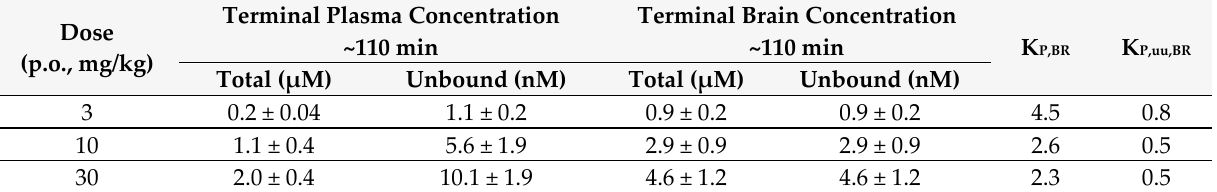
Figure 3. Effect of a single administration of HC-070 (mg/kg, p.o.) on colonic hypersensitivity in the female rat model of partial restraint stress (PRS). ( A ) Results of the colonic distension threshold (mmHg) evoked by the colorectal distension test are expressed as the mean of three trials, the error bars represent SD, n = 10/treatment group, and each symbol represents an individual data point. Percentages are expressed as colonic anti-hypersensitivity activity of HC-070 and morphine, or as percentage of variation as compared to naive animals. **, ***: p < 0.01 and p < 0.001, respectively, as compared to the vehicle-treated PRS group, Dunnett’s test after significant one-way ANOVA. ( B ) Average exposures of terminal plasma and brain at the end of the study from female rats dosed orally with 3, 10, or 30 mg/kg of HC-070. Error bars show standard deviation. Unbound fraction in rat plasma was 0.5% (0.005), and 0.1% (0.001) in rat brain. 2.4. Mechanical Anti-Hypersensitivity Effect of TRPC4/5 Antagonist HC-070 in the Model of Chronic Constriction Injury in Male Rats Sciatic nerve ligation, a chronic constriction injury (CCI), induced statistically significant mechanical hypersensitivity in the operated right hindpaw two weeks after the surgery (interaction between time and treatment: F20,216 = 14.59, p < 0.0001; p < 0.001, post hoc test between CCI operated and sham groups; Figure 4A). The non-injured left control paw withdrawal threshold was in the range of 306–326 g, while nerve injury decreased the ipsilateral paw withdrawal threshold to a level of 194–204 g ( p < 0.01 or p < 0.001, as compared within each CCI operated group; Figure 4A). During the established phase (fourteen days after surgery), orally administered HC-070 and subcutaneous morphine administration had a significant main effect on mechanical hypersensitivity induced by CCI ( p < 0.0001). Post hoc testing indicated that mechanical hypersensitivity induced by CCI in the late phase was significantly attenuated by HC-070 at 30 mg/kg and 10 mg/kg at 45 and 75 min post-dosing, respectively. Additionally, morphine at 3 mg/kg at 45, 75, and 105 min post-administration induced a significant anti-hypersensitivity effect in CCI operated animals (Figure 4A). Moreover, these studied compounds had a significant effect on percentual reversal of CCI-induced mechanical hypersensitivity in the injured paw